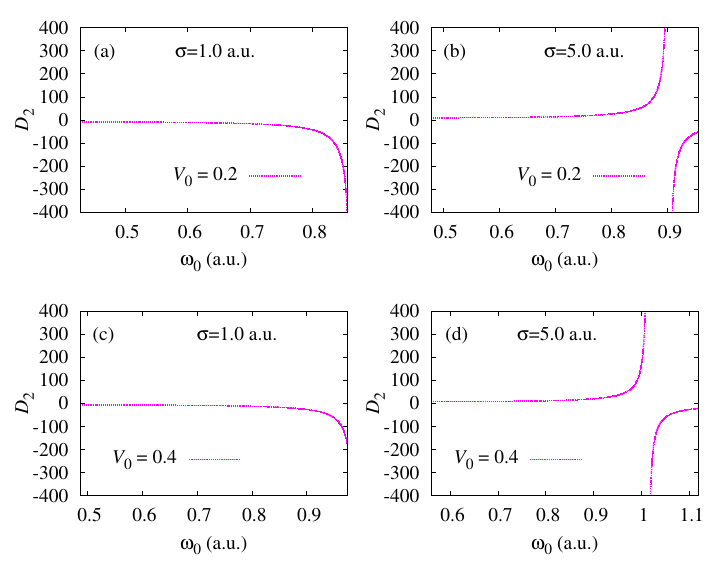
Figure 1. Variation of two-photon 1 s → 2 s transition probability amplitude with frequency of incoming photons, ω 0 , for ( a ) V 0 = 0.2 a.u. and σ = 1.0 a.u.; ( b ) V 0 = 0.2 a.u. and σ = 5.0 a.u.; ( c ) V 0 = 0.4 a.u. and σ = 1.0 a.u.; ( d ) V 0 = 0.4 a.u. and σ = 5.0